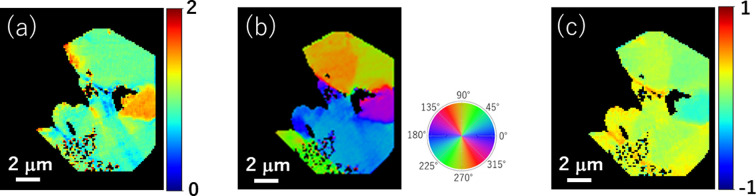
Maps of (a) amplitude (A), (b) orientation angle (θori), and (c) background (B) in natural spherical graphite.